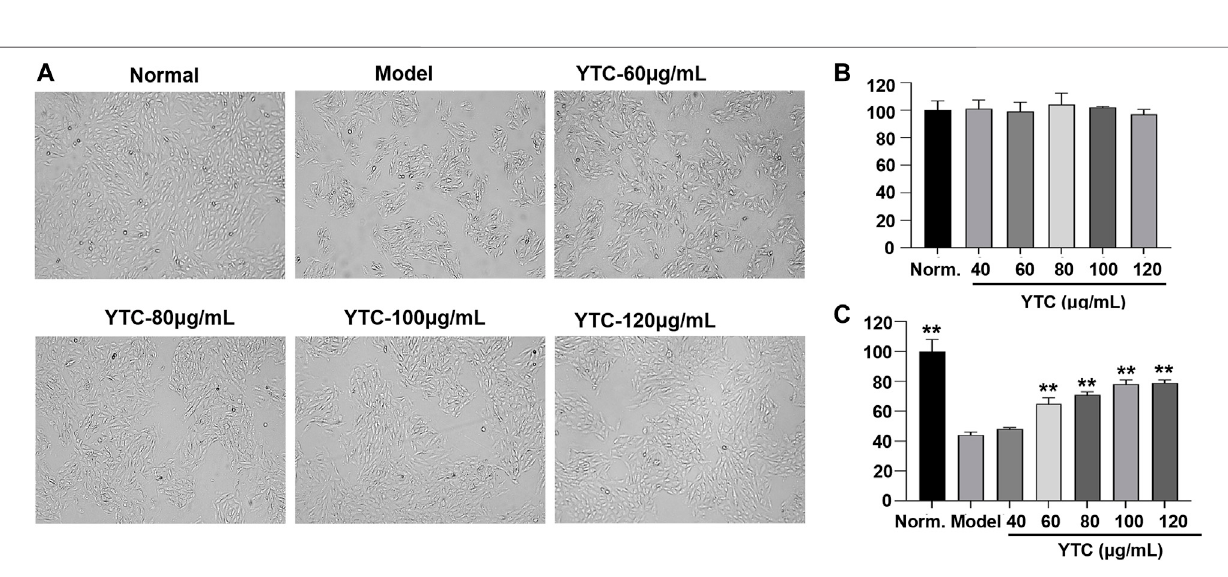
Frontiers in Pharmacology |